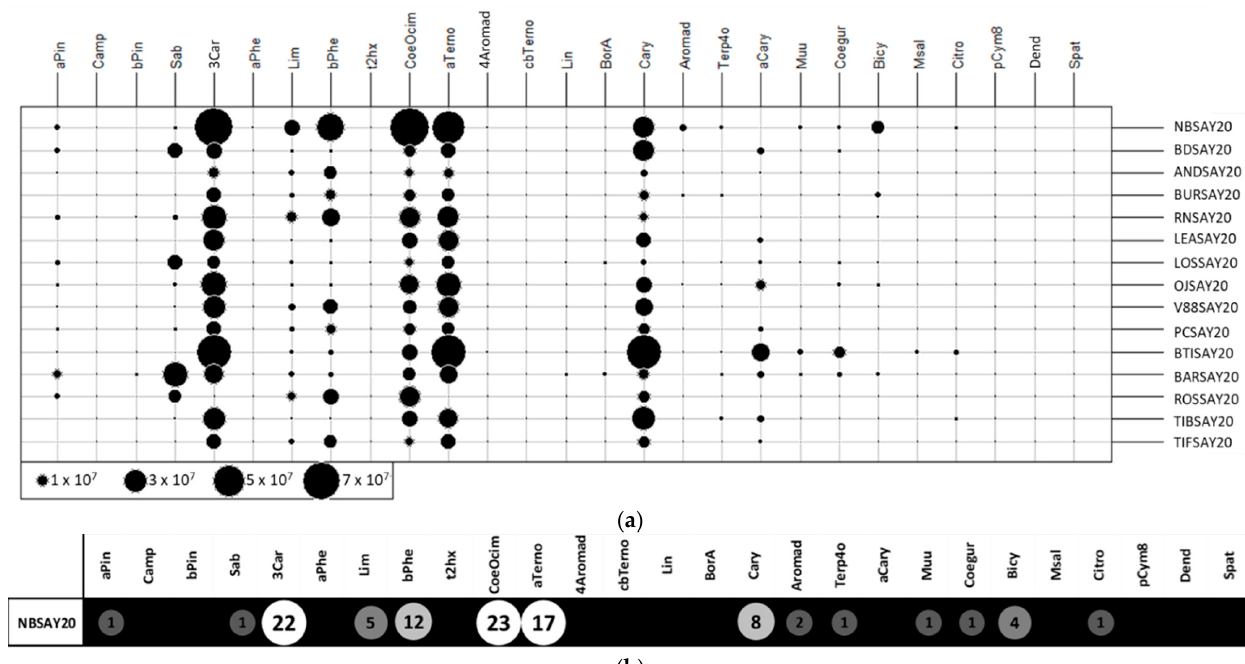
Figure 3. Two-dimensional table plot with proportional circles for peak areas of each volatile compound: ( a ) raw data and ( b ) relative abundance.